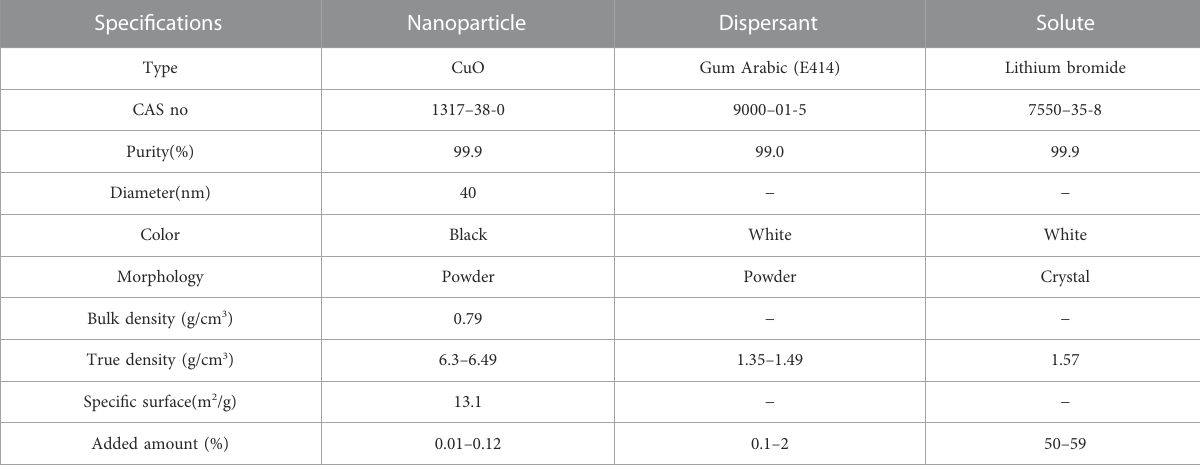
TABLE 2 Material information of